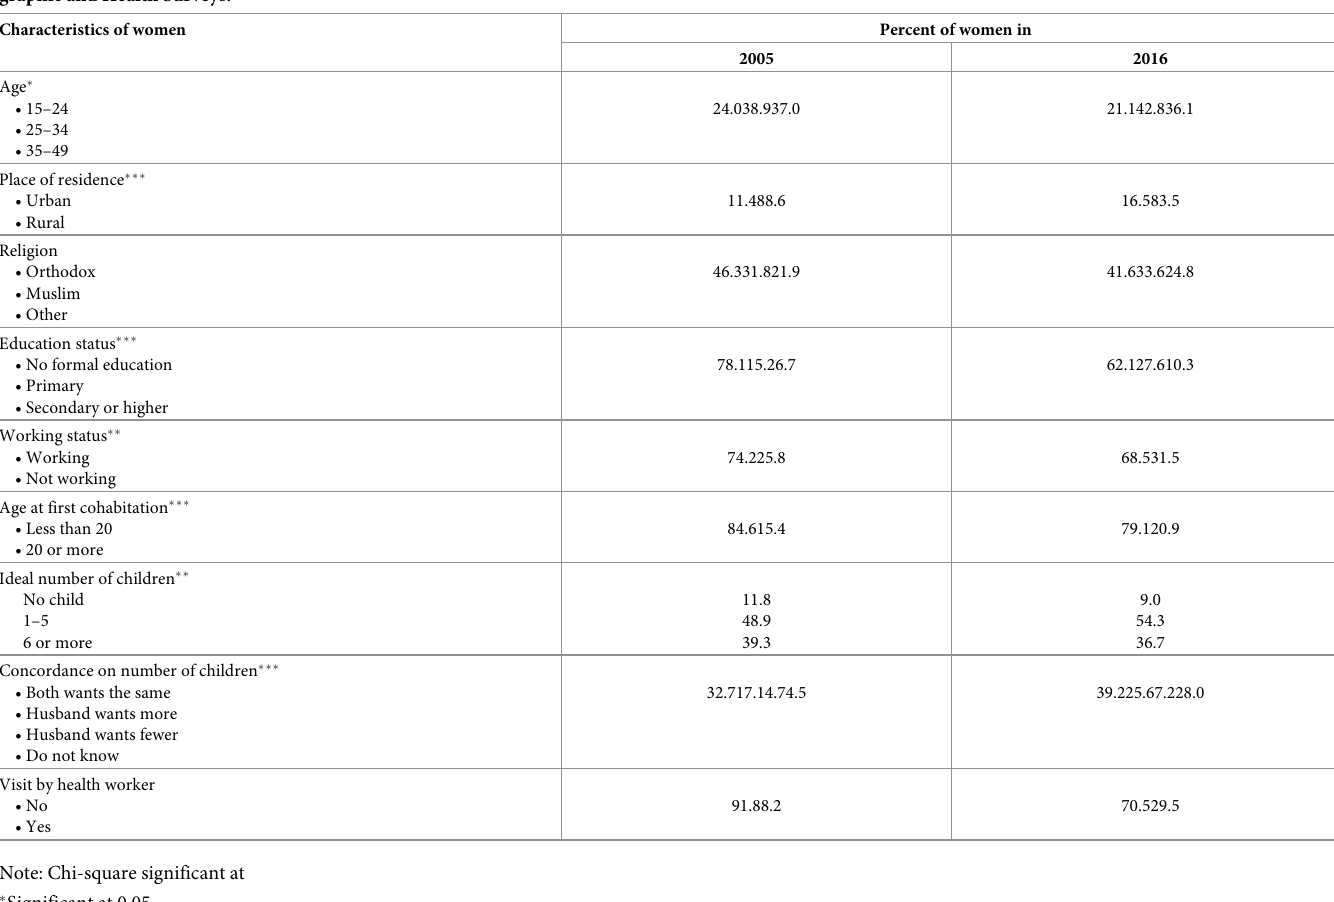
Table 1. Percentage distribution of selected characteristics of married or in-union reproductive-age women in Ethiopia from the 2005 and 2016 Ethiopian Demo- graphic and Health Surveys. Characteristics of